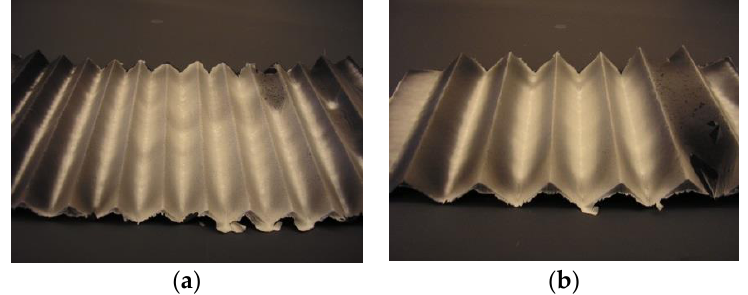
Figure 6. Photographs showing details of collected nanofibers: ( a ) 1 × 1 cm V-shaped cardboard substrate and ( b ) 2 × 2 cm V-shaped cardboard substrate after 1 h of electrospinning.